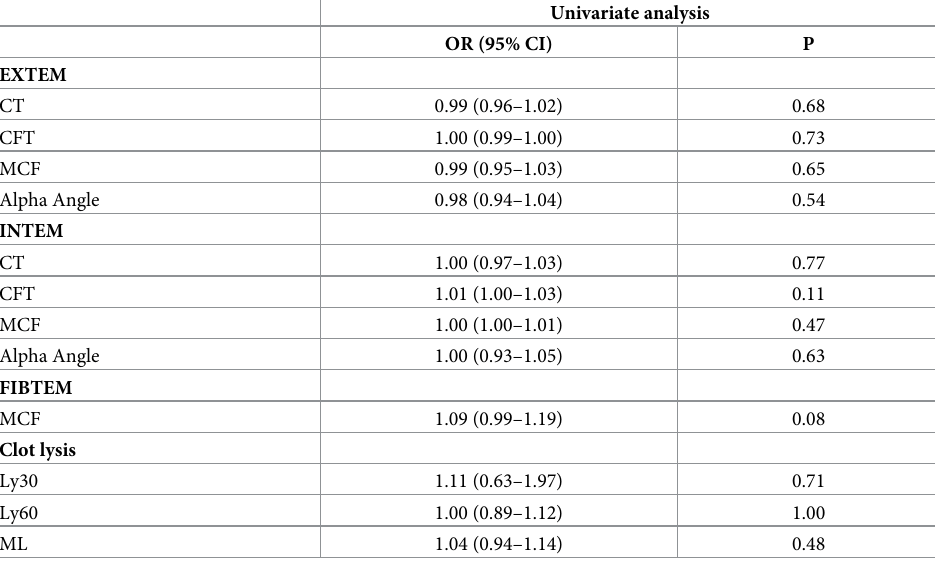
Table 3. Univariate analysis of association between TE parameters and mortality/transplantation in patients with liver